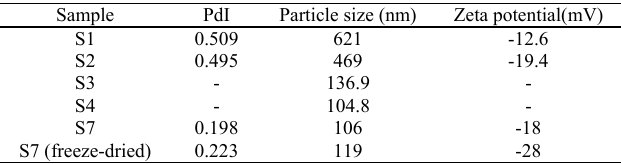
Table 2. The size of PDI, Particle size and Zeta potential in samples